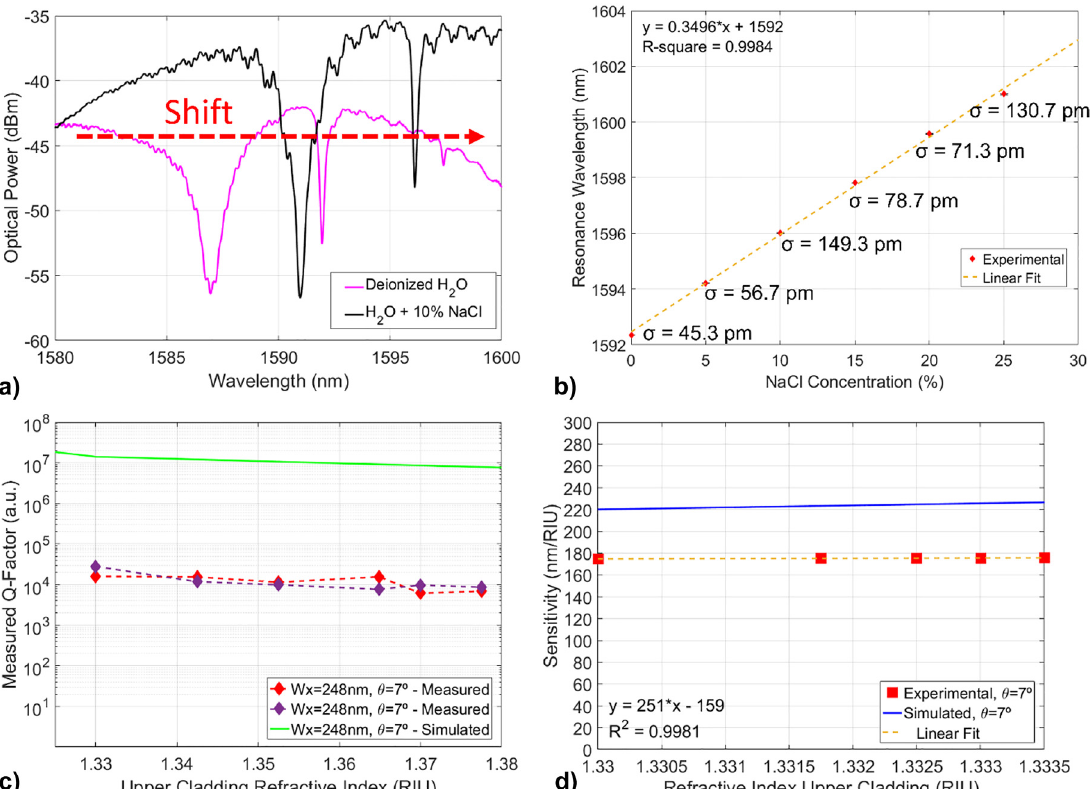
Figure 8: PhC cavity sensing measurements, (a) Optical spectra of a nanobeam device with the presence of de-ionised water (magenta) and [10%] NaCl solution (black) on top, with the red dashed line indicating the resonance shift with the different upper cladding RI, (b) Shift of the resonance wavelength of the microcavity with salt concentration, plotted with error bars and standard deviations, (c) measured Q-factors of the microcavity resonances with upper cladding RI, compared to the simulated Q-factor (green) for the same device architecture and (d) measured sensitivity of the microcavity against increasing upper cladding RI (experimental datapoints taken in the region of RI from 1.3300 to